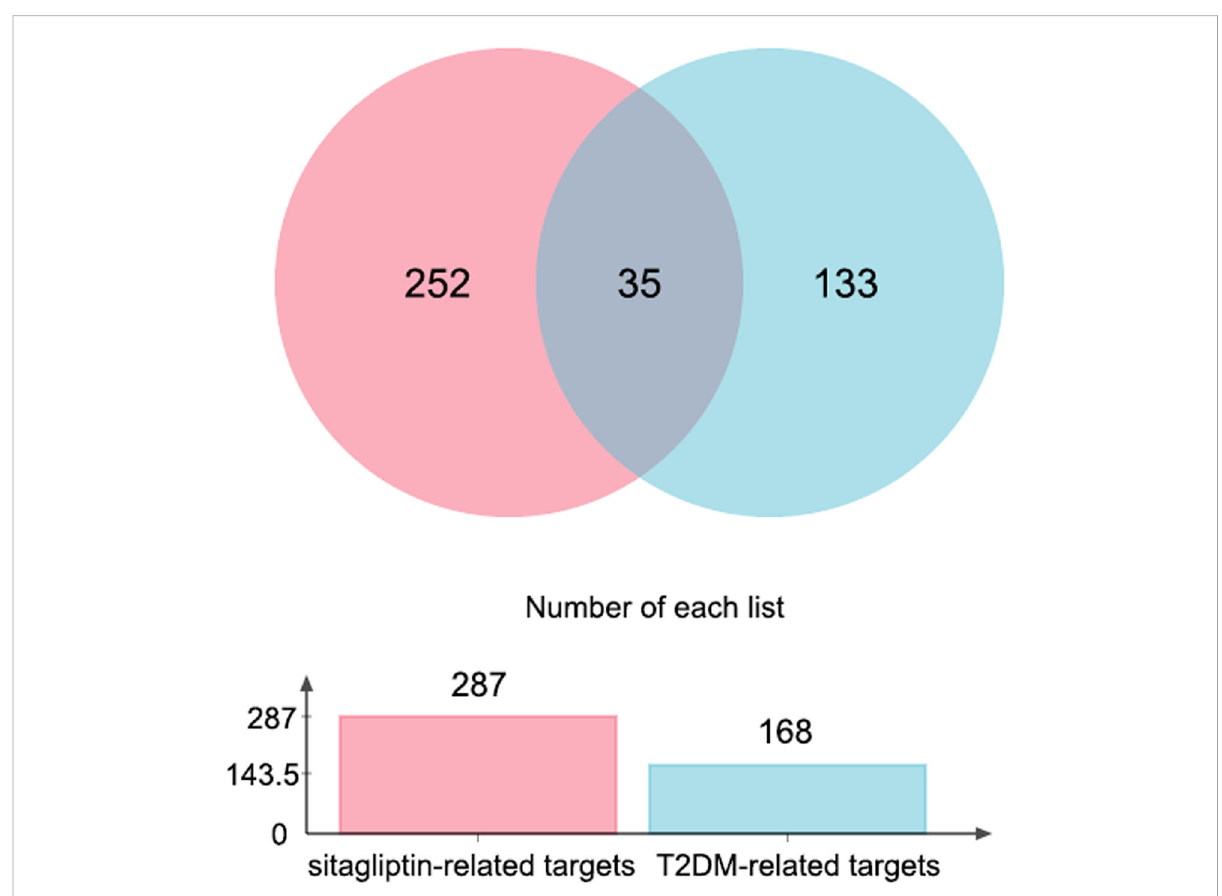
FIGURE 1 Venn graph of sitagliptin-related targets and T2DM-related